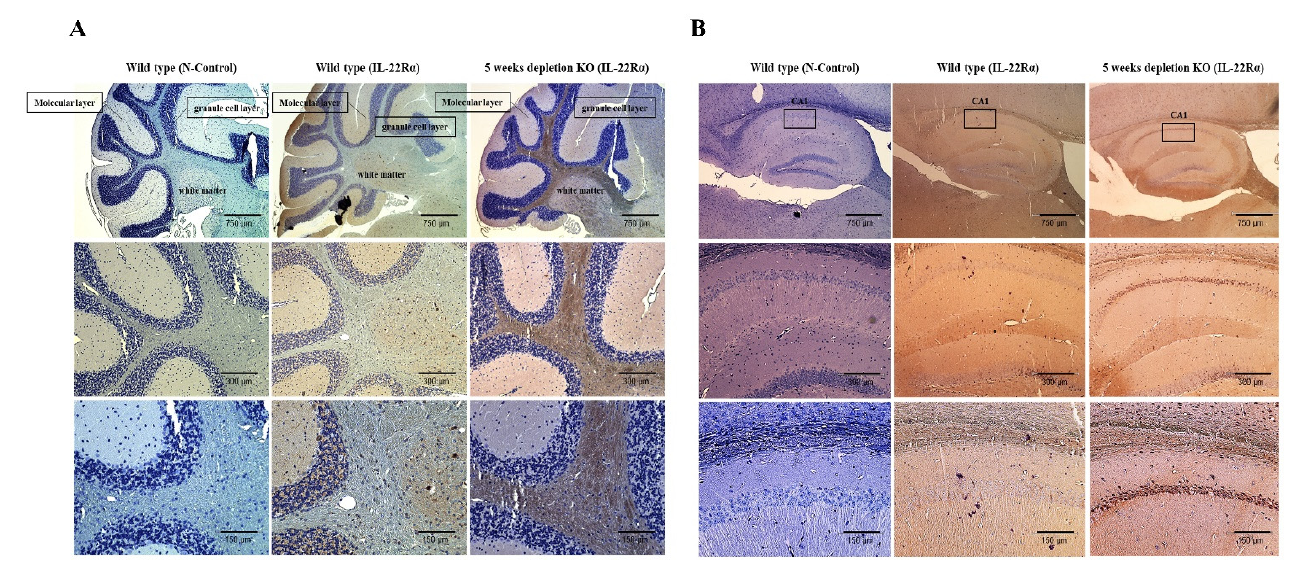
Figure 4. IL-22R α expression is increased in the Gulo (-/-) mouse brain upon inflammation. ( A ) Cerebellum. ( B ) Hippocampus, CA1 region is localized to the stratum pyramidal and apical dendritic arborization extending into the stratum radiatum. Immunohistochemical staining of the sagittal sections of the WT and 5 weeks Gulo (-/-) mouse brain and then paraffin-embedded tissues were sectioned with 4 µm thickness and incubated with a primary antibody against IL-22R α and a biotinylated anti-rabbit antibody. Nuclei were counterstained with hematoxylin. Scale bar, 150 µm .